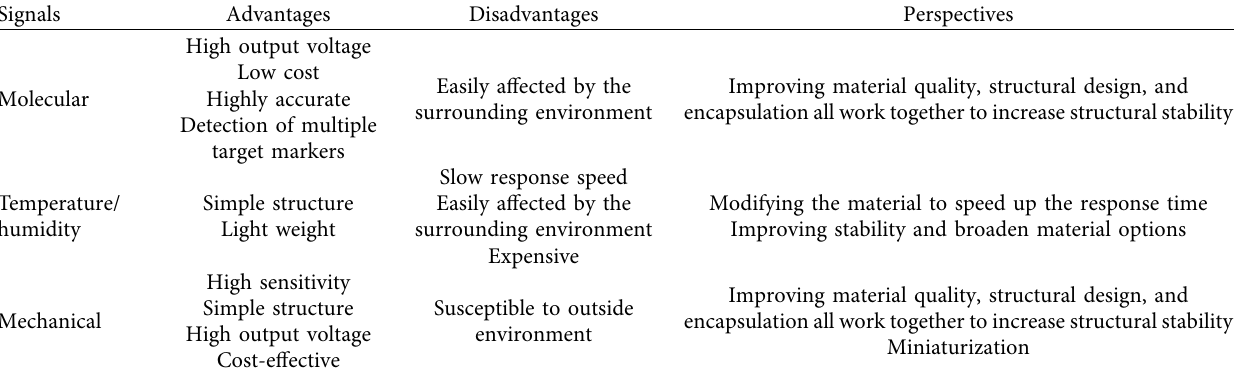
Table 2: Recent auto-charged breathing monitoring systems are summarized and compared in terms of their advantages and challenges.